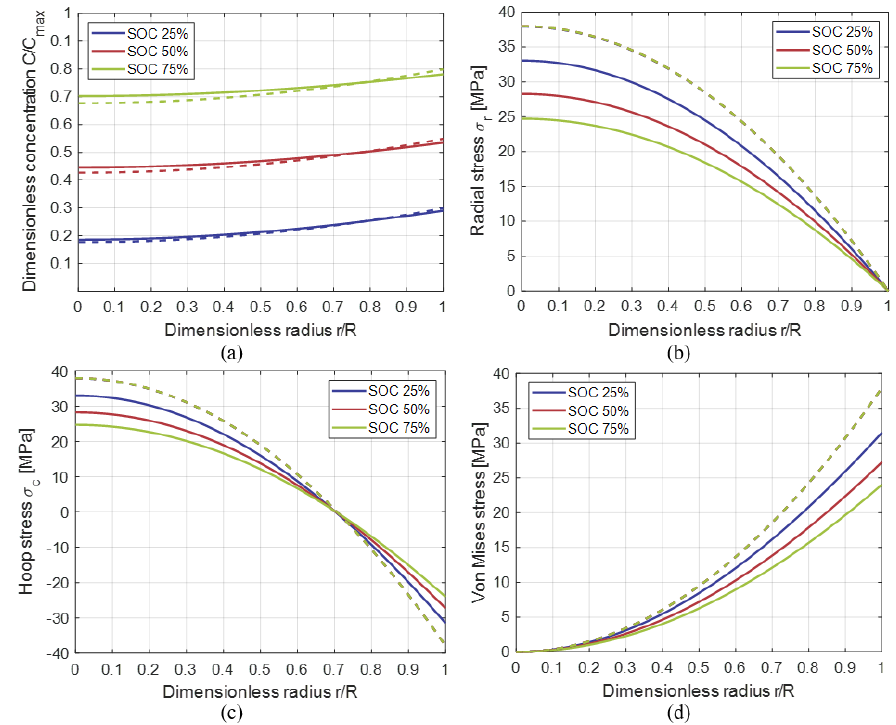
Figure 4. Lithium concentration ( a ), radial stress ( b ), hoop stress ( c ) and Von Mises stress ( d ) for different SOC levels in galvanostatic insertion in anode material. Dashed lines refer to the uncoupled model and solid lines refer to the coupled model.